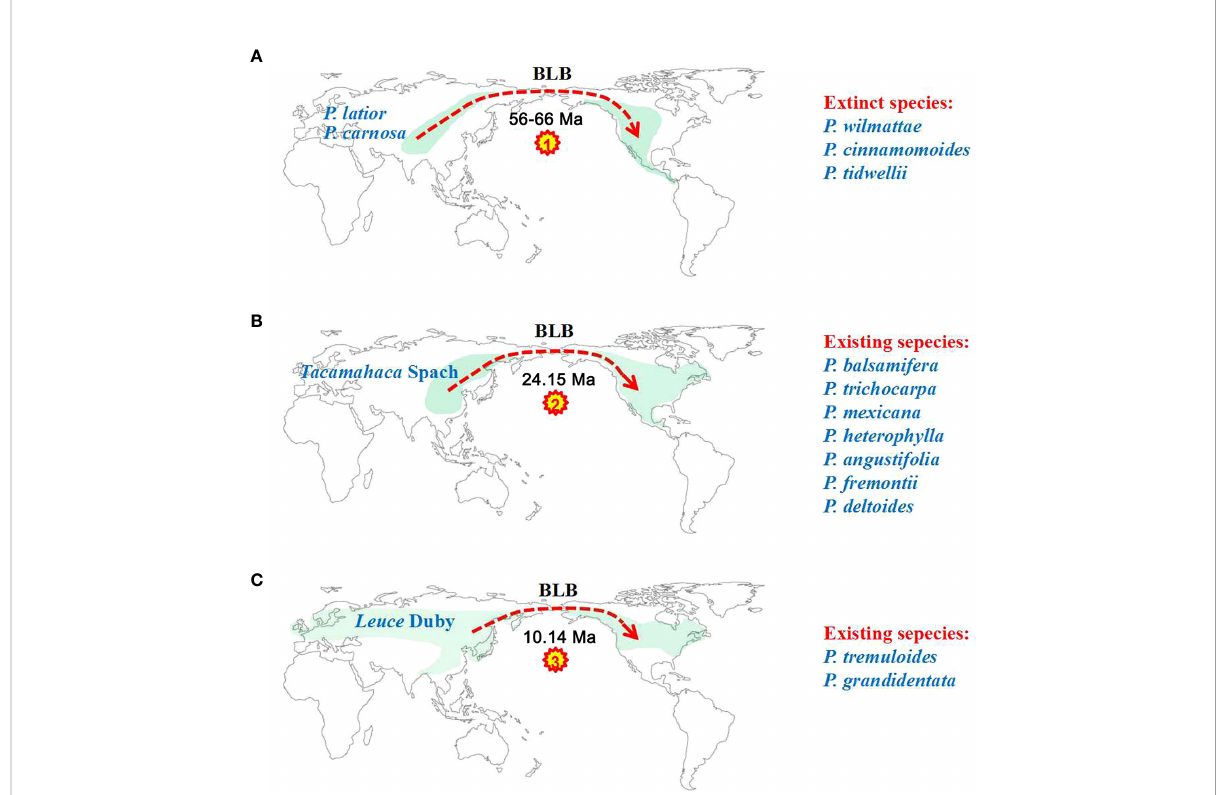
FIGURE 5 Three colonization events of North America by Eurasian poplar taxa via the BLB. (A) Descendants of the fi rst colonization event of North America eventually became extinct. (B) The second colonization of Tacamahaca section species of North America from East Asia produced modern North American Populus species. (C) The third colonization event of North America formed P. tremuloides and P. grandidentata